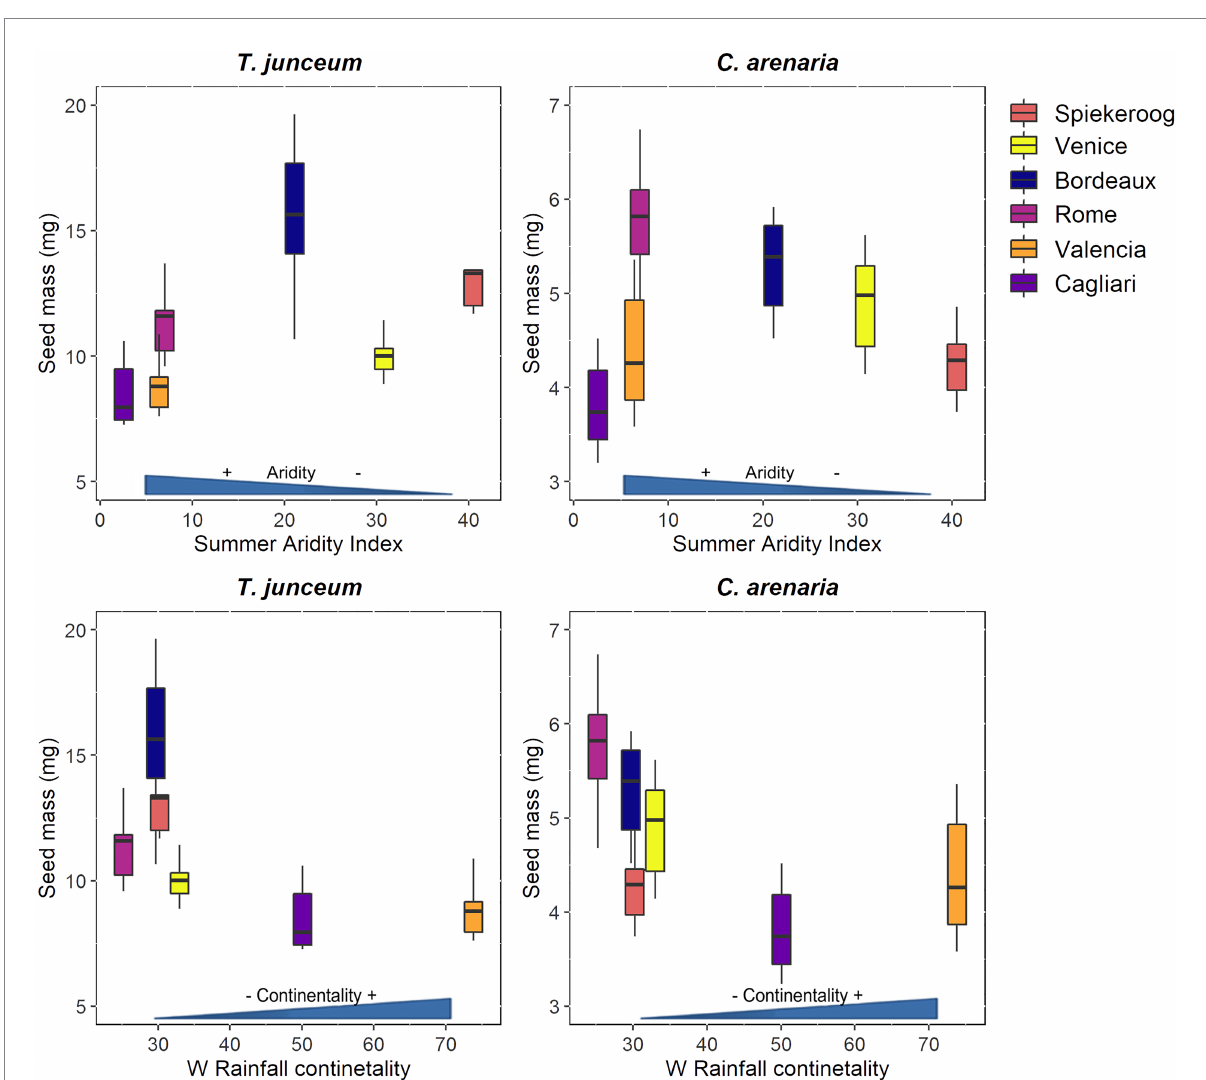
FIGURE 2 Seed mass of Thinopyrum junceum and Calamagrostis arenaria for each population. The summer aridity index and the rainfall continentality index of each population are shown on axis x . Color-blind-friendly palette was used for the figure (Garnier et al., 2021; Katsnelson, 2021).